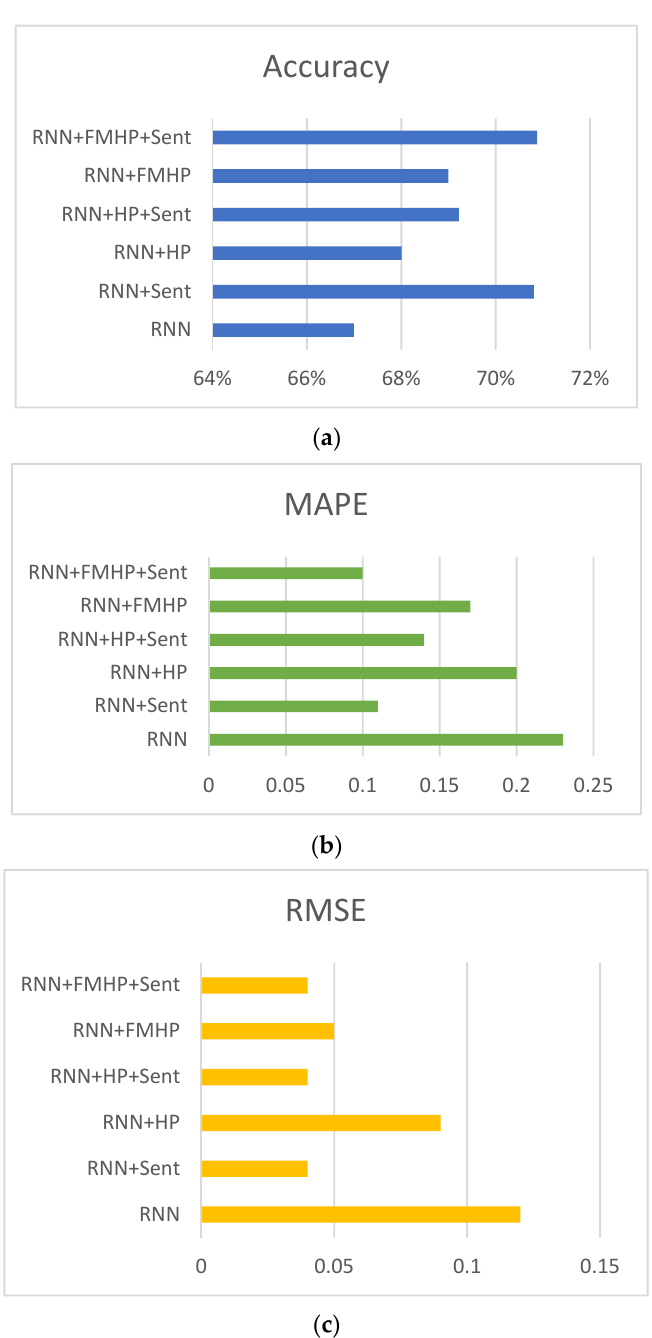
Figure 9. Performance of RNN in predicting the closing price of AAPL ( a ) prediction accuracy, ( b ) MAPE, and ( c ) RMSE.